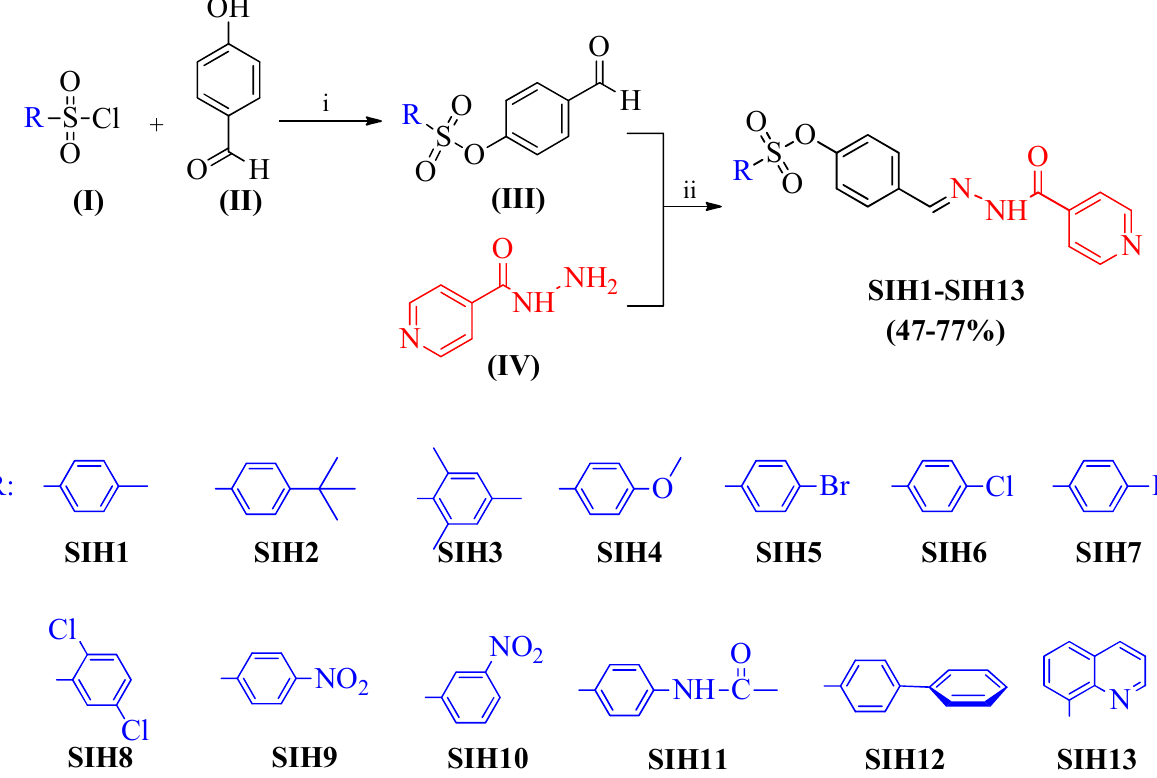
Figure 3. Design strategy of the studied molecules SIH1–SIH13